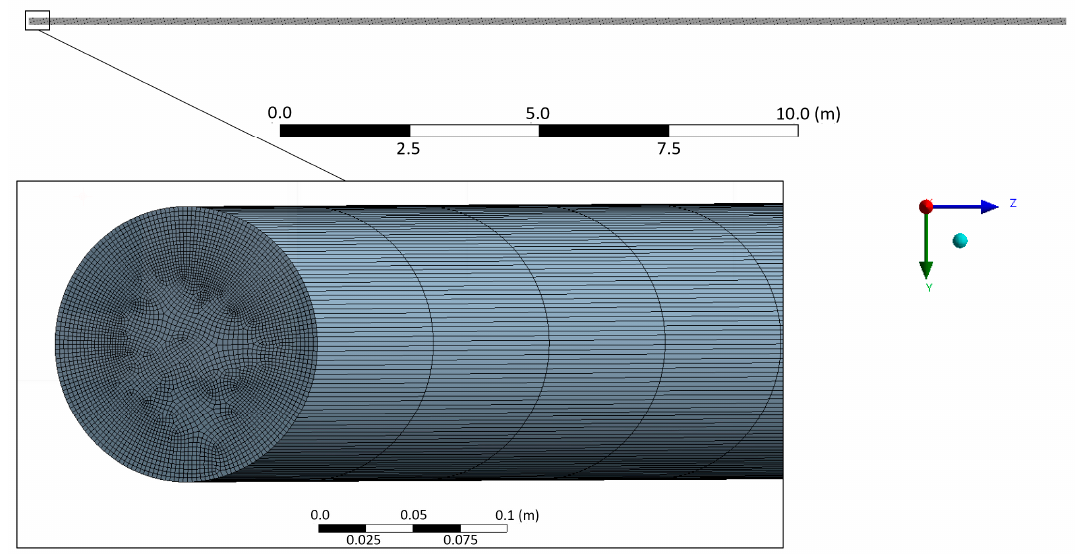
Figure 2. Geometry of the computational domain and the mesh.